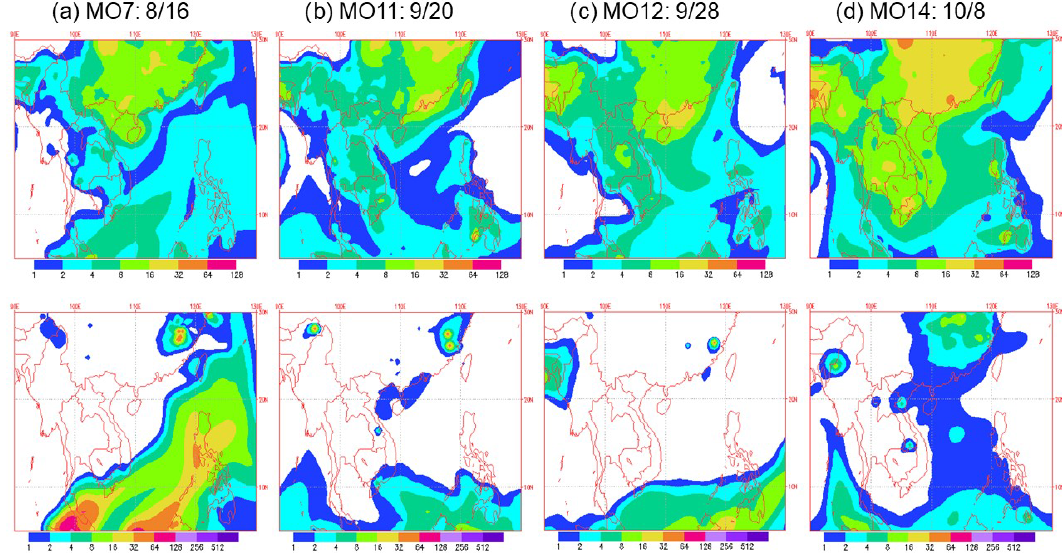
Figure 4. NAAPS model snapshots corresponding to conditions at the stop time of sample sets (a) MO7, (b) MO11, and (c) MO12 and (d) 3h after the sample stop time for MO14. The top row of figures is anthropogenic and biogenic fine aerosol (ABF) surface concentration (µgm − 3 ), while the bottom row is biomass burning smoke surface concentration (µgm − 3